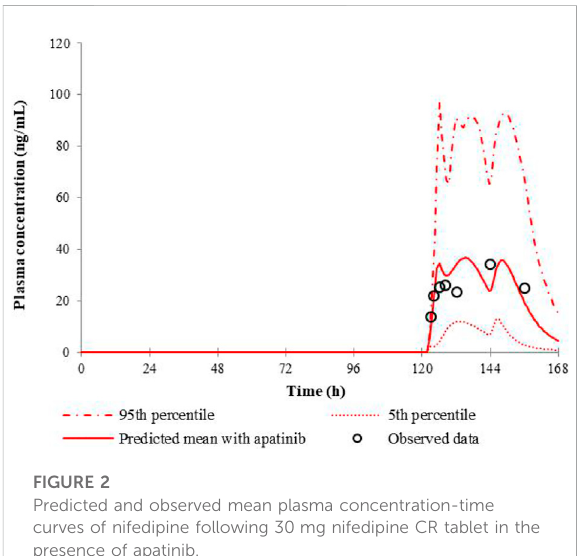
FIGURE 2 Predicted and observed mean plasma